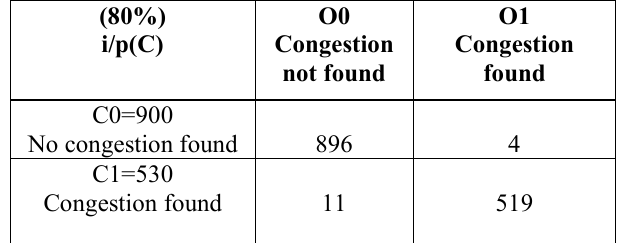
Table 4. Training and validation of the statistical